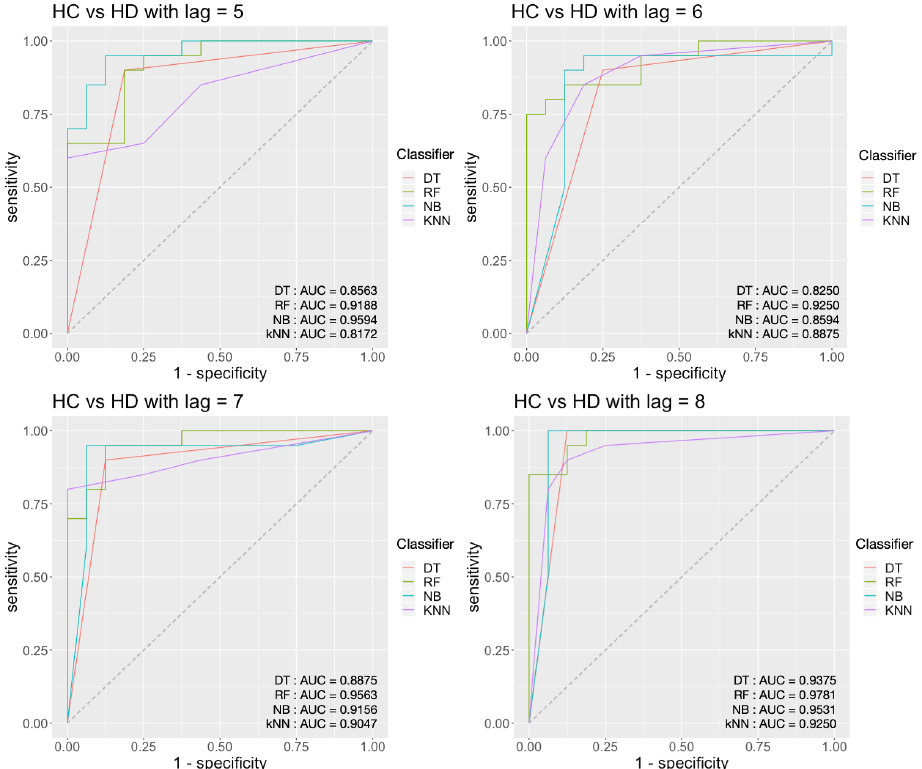
Figure 12. Classification results for HC vs. HD with an embedding time delay lag of 5, 6, 7 and 8.